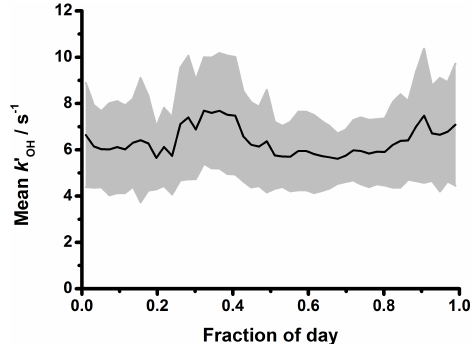
Figure 9. Diurnal average for observed OH reactivity (15min av- erages) during in York (19 May to 16 June 2014). Shaded areas represent the measurement variability from day to